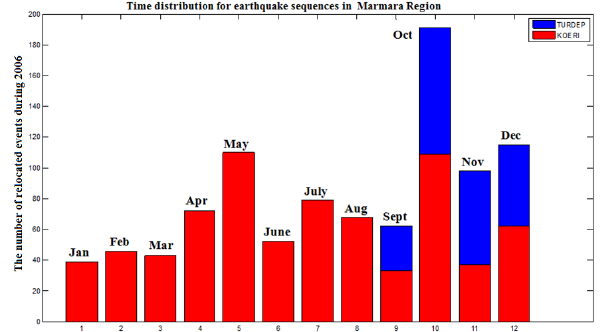
Fig. 3. The relocated events from the KOERI and the TUBITAK stations are marked red and blue from January to December, 2006 respectively. Here we merged only the TURDEP data with the KO- ERI data for the last 4 months because since the TURDEP stations have been started from September